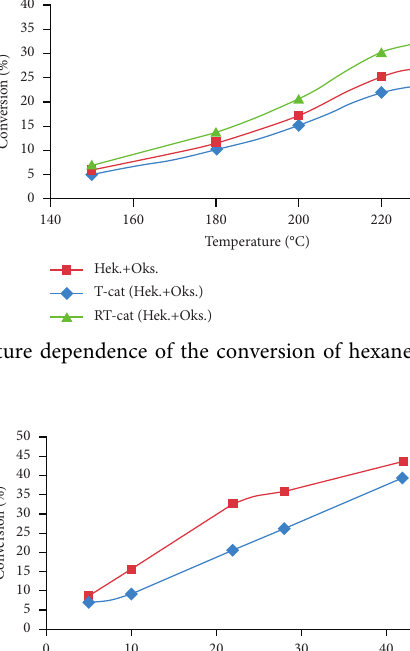
2 O 3 catalyst on the initial absorbed dose in air.